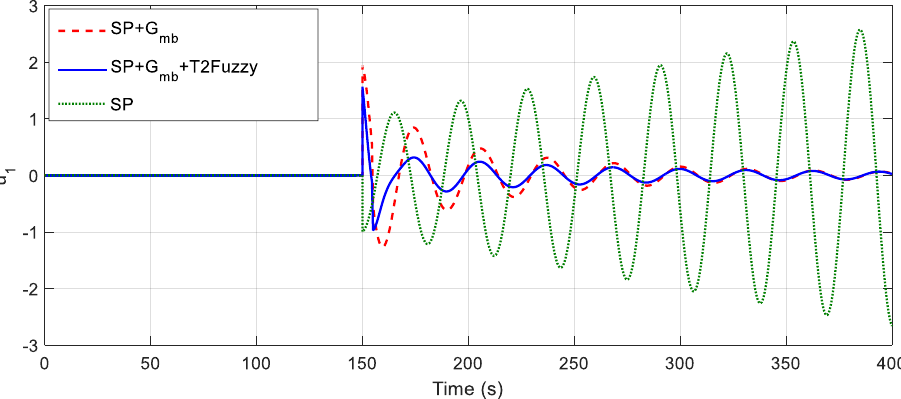
Figure 17. The control signal 𝑢 1 for all three methods by applying uncertainty.